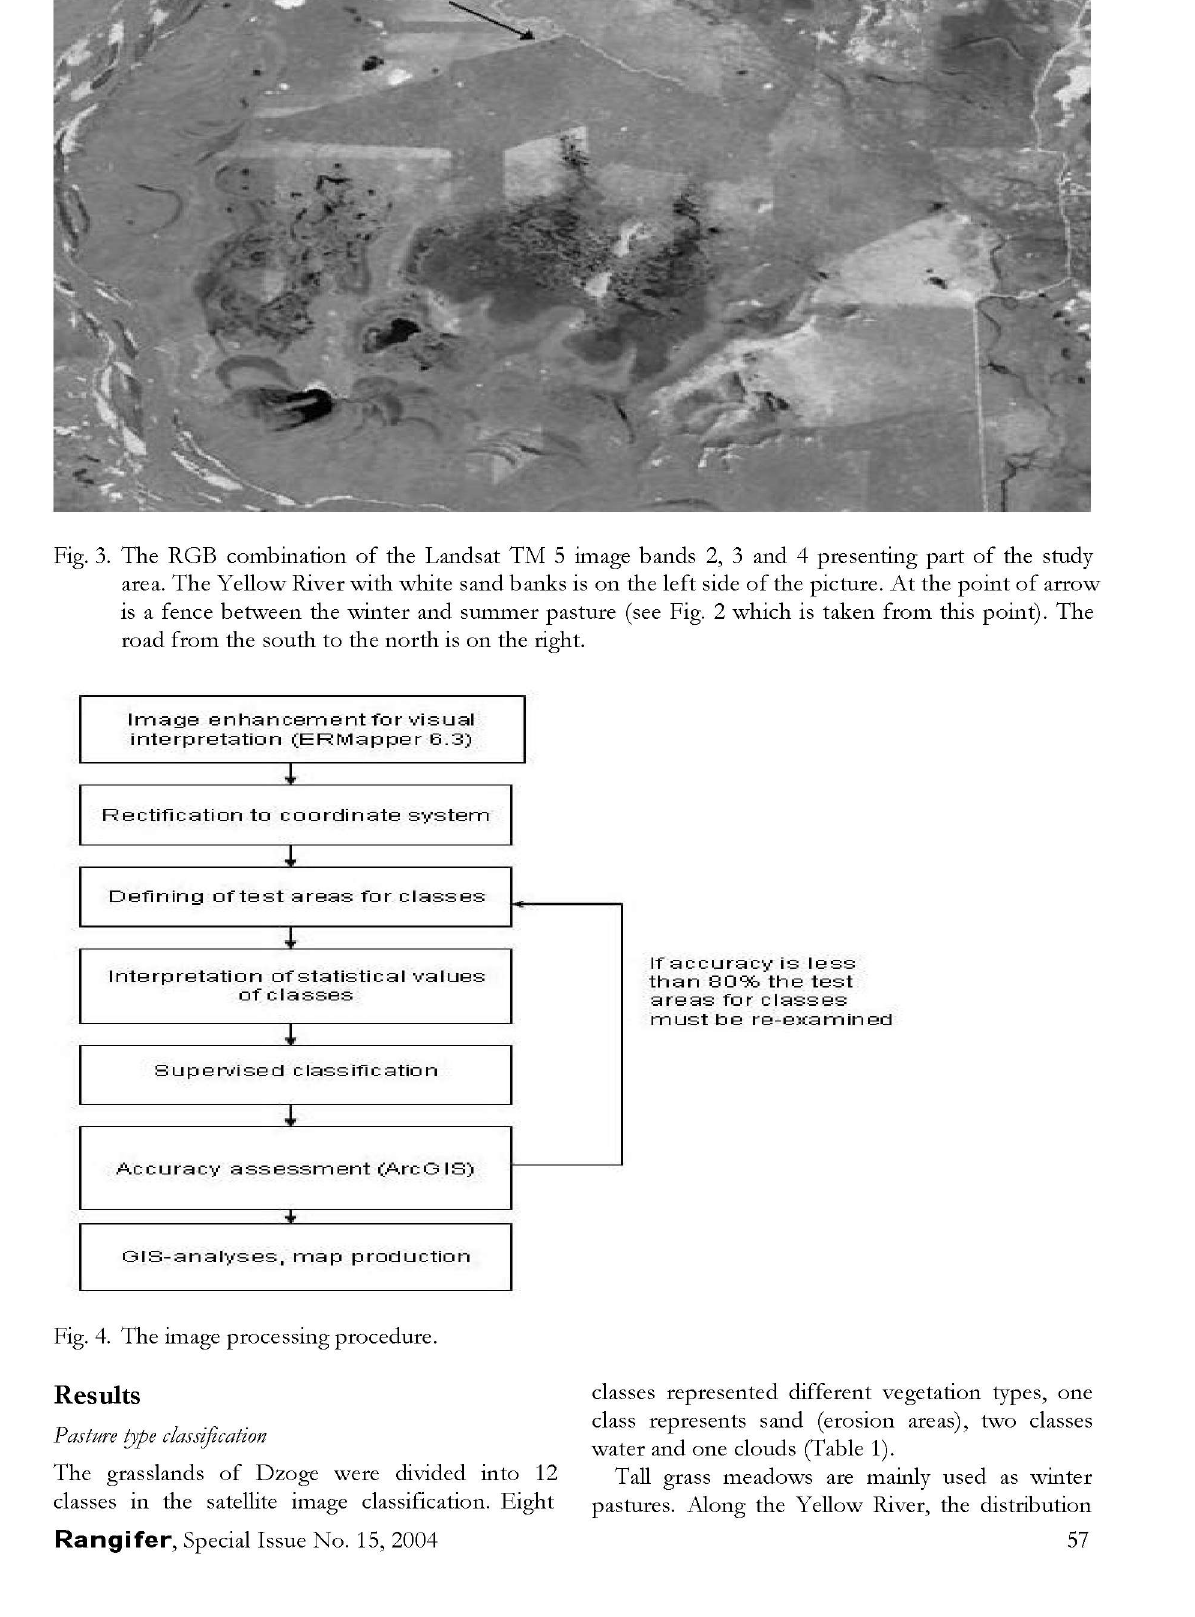
Fig. 4. The image processing procedure. Results classes represented different vegetation types, one Pasture type classification